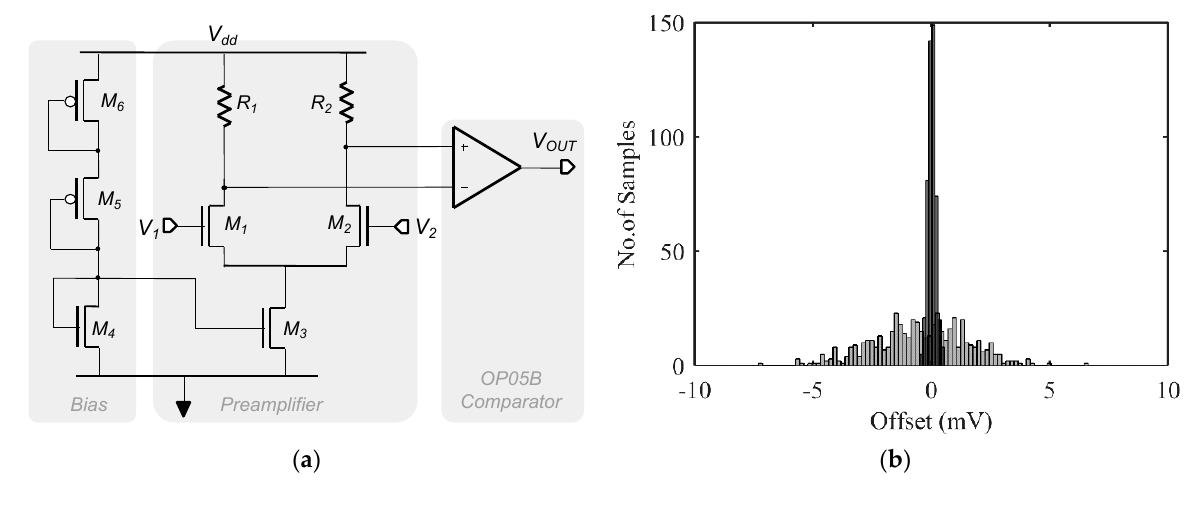
Figure 8. ( a ) A simple design to reduce offset of an existing comparator, ( b ) Monte Carlo simulations of input-referred offset of comparator IP (in grey) and a pre-amplified comparator (in black).